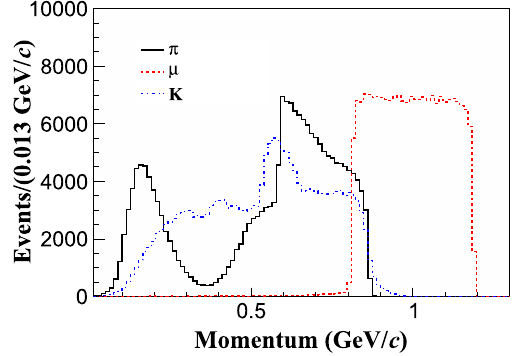
Fig. 3 The momentum of π , μ and K from e + e − → D − s D + s , D − s → K + K − π − , D + s → μ + ν μ signal MC. The channel is generated according to the amplitude of the Dalitz plot, which describes a three-body decay process including resonances, such as D − s → φ( 1020 )π − → K + K − π − , D − s → f 0 ( 980 )π −